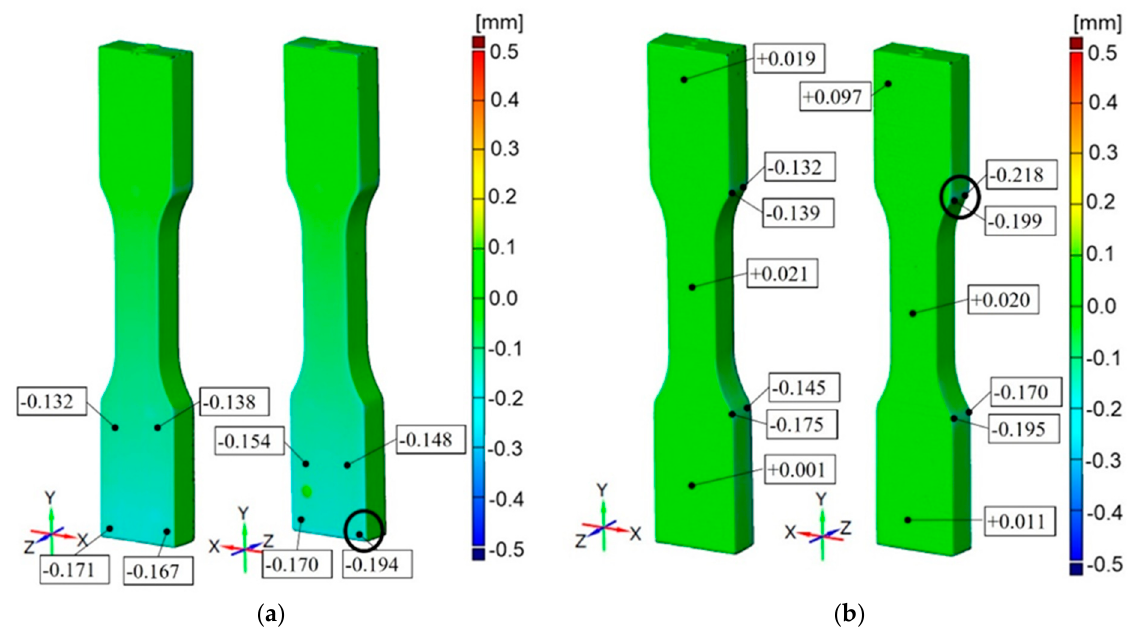
Figure 13. Geometric accuracy [mm] for the specimens made of Vero White Plus material: ( a ) Raster orientation: horizontal (X-axis), specimen ID: 2; ( b ): Raster orientation: vertical (Z-axis), specimen ID: 5.